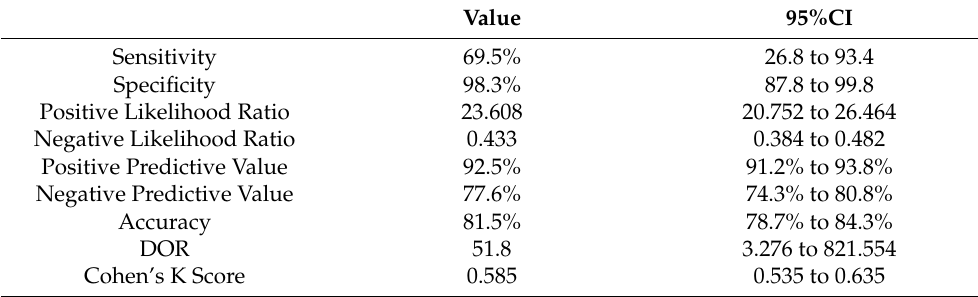
Figure 3. A forest plot representing the estimated specificity of SARS-CoV-2 Real-Time Quantitative Polymerase Chain Reaction (RT-qPCR) performed on specimens of exhaled breath condensate. Pooled specificity was 98.3% (95%CI 87.8 – 99.8), with moderate heterogeneity (I 2 39.0, p = 0.178).